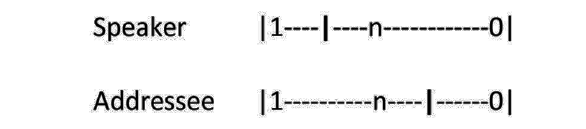
FIGURE 1 | Illustration of the territory of information of the speaker (after Kamio, 1997, p.